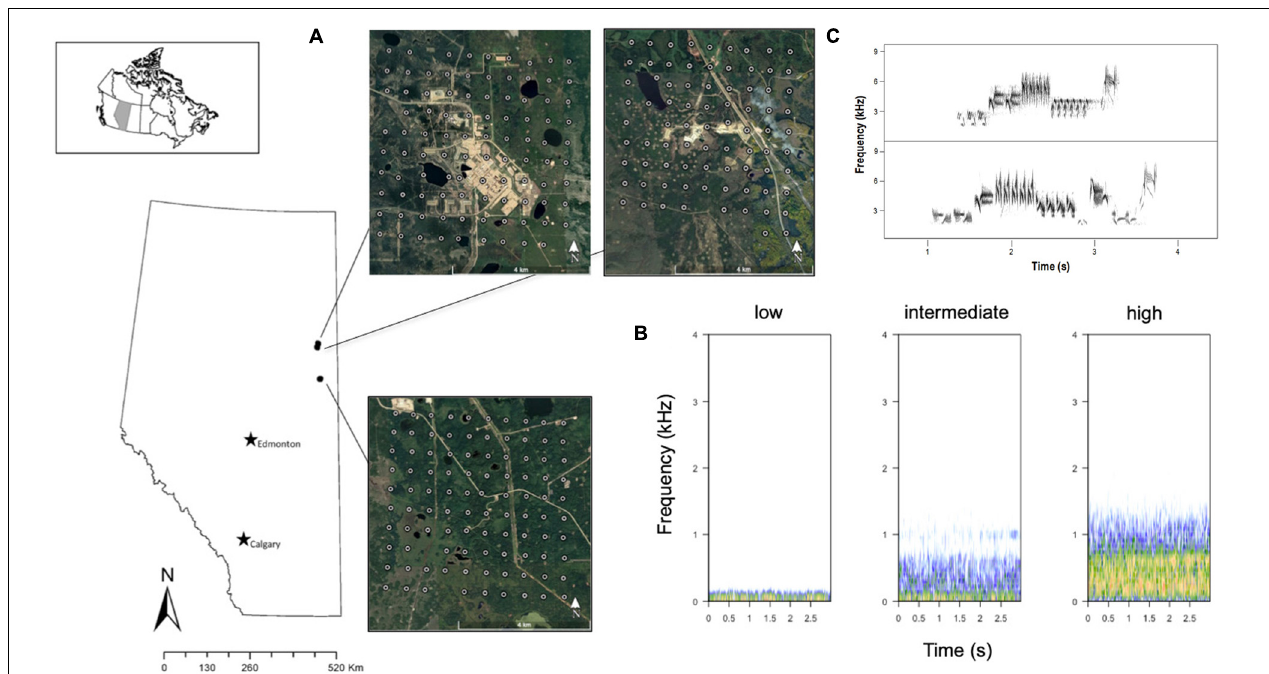
FIGURE 1 | (A) Sample design. Autonomous digital recorders deployed 600 m apart in three areas of industrial disturbances in Northern Alberta, Canada. Upper areas correspond to high and medium industrial settings. Lower area corresponds to low industrial settings. (B) Spectrograms of noise variation at a specific station in the low, intermediate, and high industrial settings areas. (C) Spectrogram of two Lincoln’s Sparrow songs showing the different elements in the song.